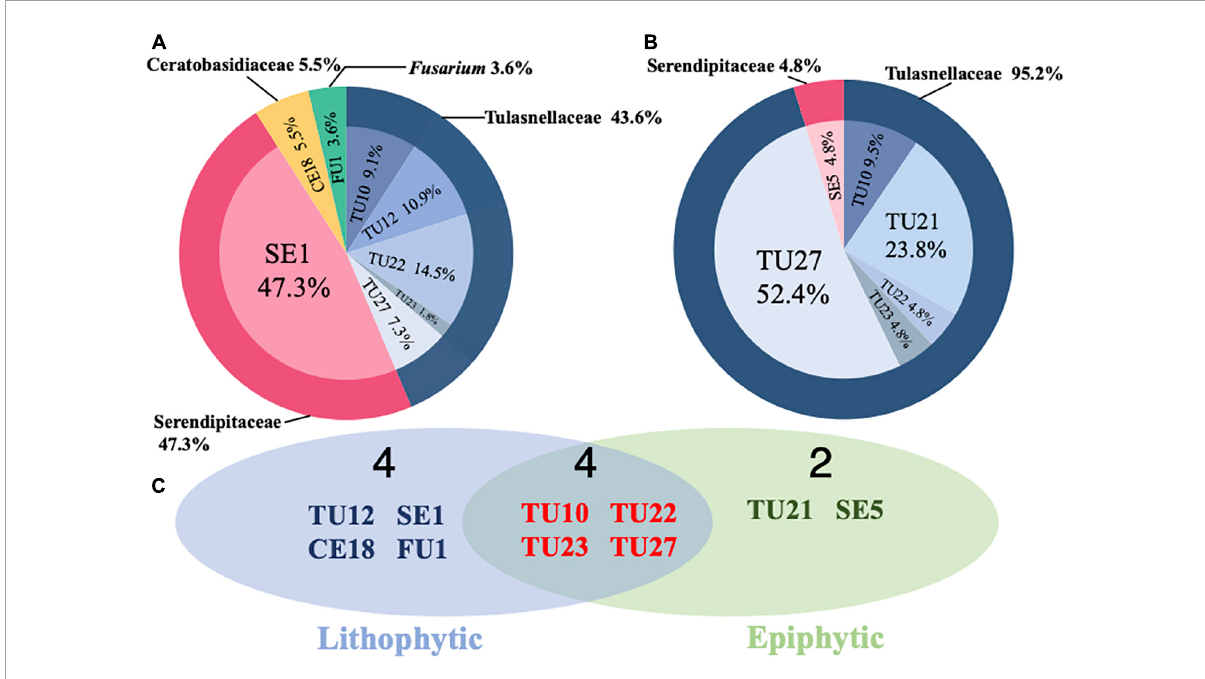
FIGURE3 Comparison of orchid mycorrhizal fungi (OMF) associating with lithophytic and epiphytic Dendrobium officinale individuals. Frequency distribution of OMF sequences detected from (A) lithophytic and (B) epiphytic individuals. (C) Venn diagrams showing the numbers of OMF